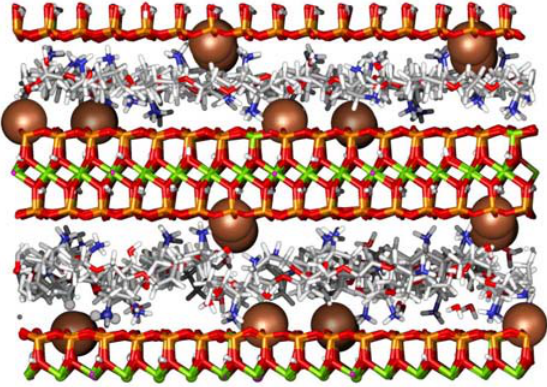
Fig. 2 – Snapshots after 1 ns of molecular dynamics simulation of the 7160 atom 33% ammonium mix (PPO-NH 2 /PPO–NH + 3 ) sys- tem showing the interlayer arrangement of ammonium cations and adjacent clay sheets. The ammonium cation is arranged to maximise H-bond and electrostatic interactions. When compared to the Na + cation, the ammonium cation is unable to sit closer to the cavities in the tetrahedral layer of the clay sheet due to steric restrictions and strong H-bond interactions with surface siloxane surface O atoms. The colour scheme is: C gray, H white, O red, N blue, Si orange, Al green, Na +